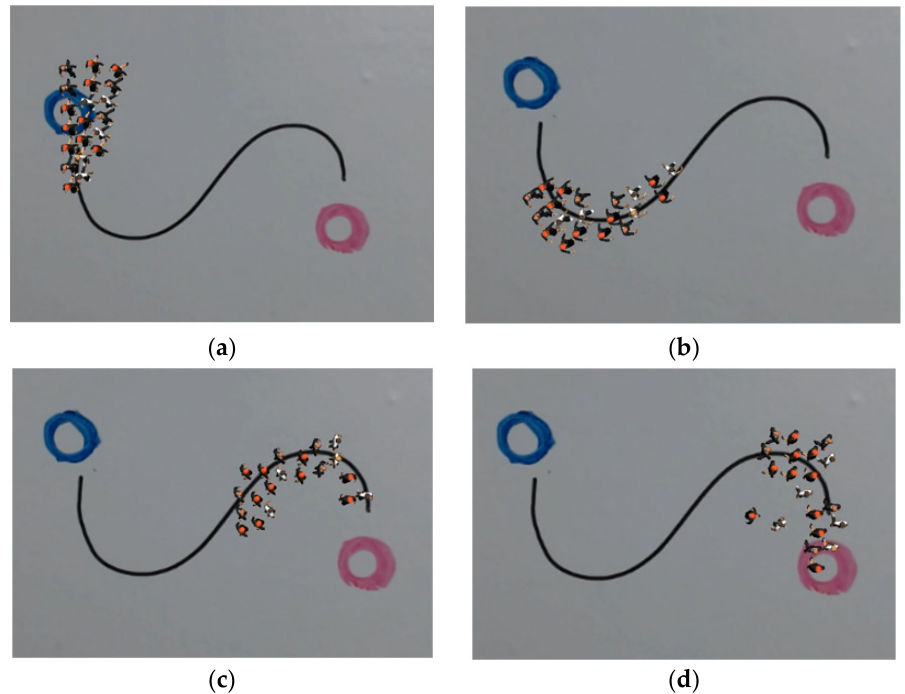
Figure 11. Crowds moving along the path from the starting and ending point. Note that there is no inter-penetration between characters during the animation. The figures from ( a – d ) are crowd simulation results over time where ( a ) is starting and ( d ) is the ending scene.